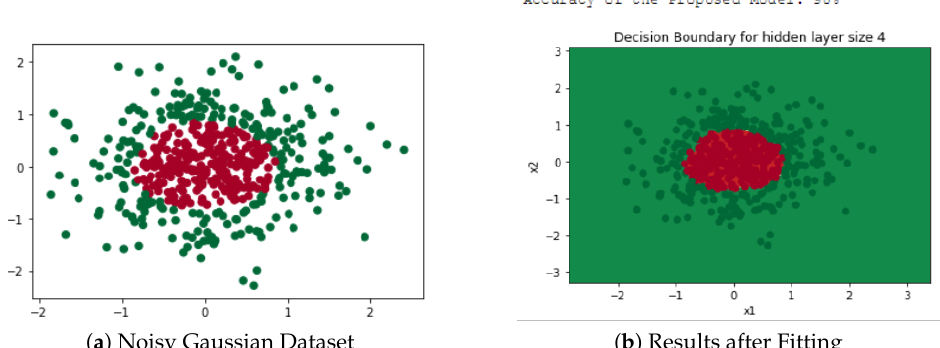
Figure 13. Visualization of the noisy Gaussian dataset and results after fitting the DTBDNN model into the noisy Gaussian dataset.